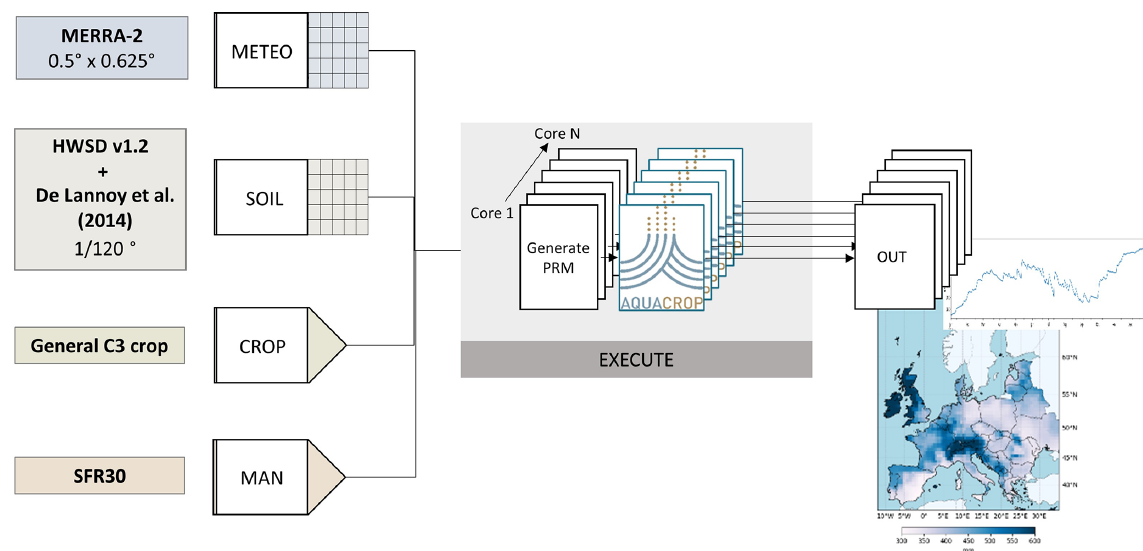
Figure 1. Flowchart of the regional model setup with gridded meteorological and soil input data as well as generic crop and management input data indicated on the left side. The parallel computing system with a maximum of N cores can execute N pixels at the same time. The composited output files can then be visualized as maps or time